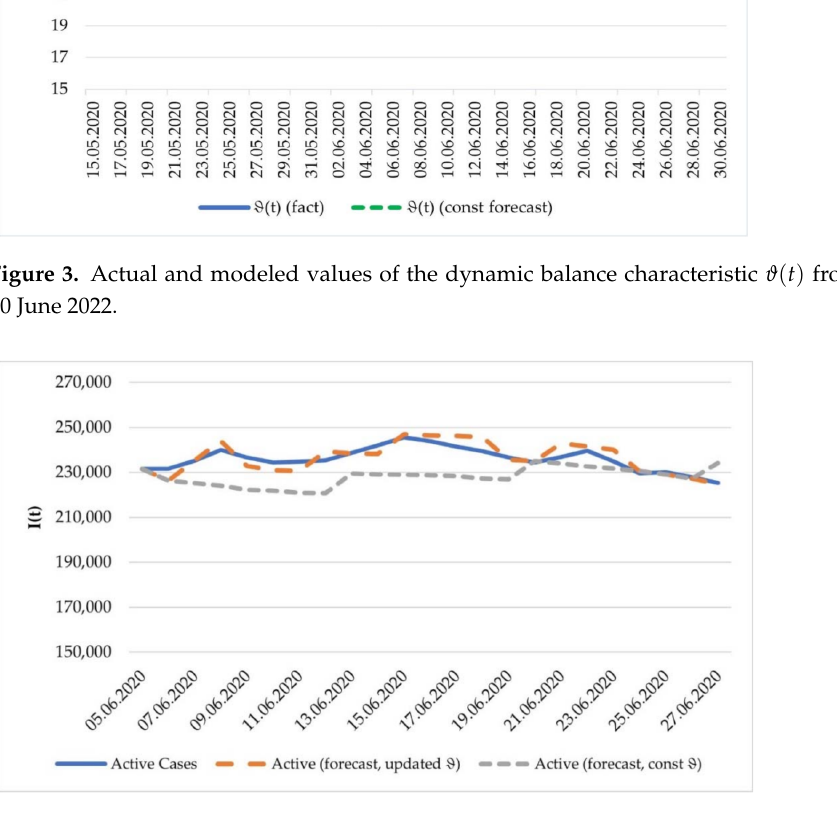
Figure 4. Dynamics of I ( t ) , the actual and modeled trajectories in the interval from 6 June to 30 June 2020.